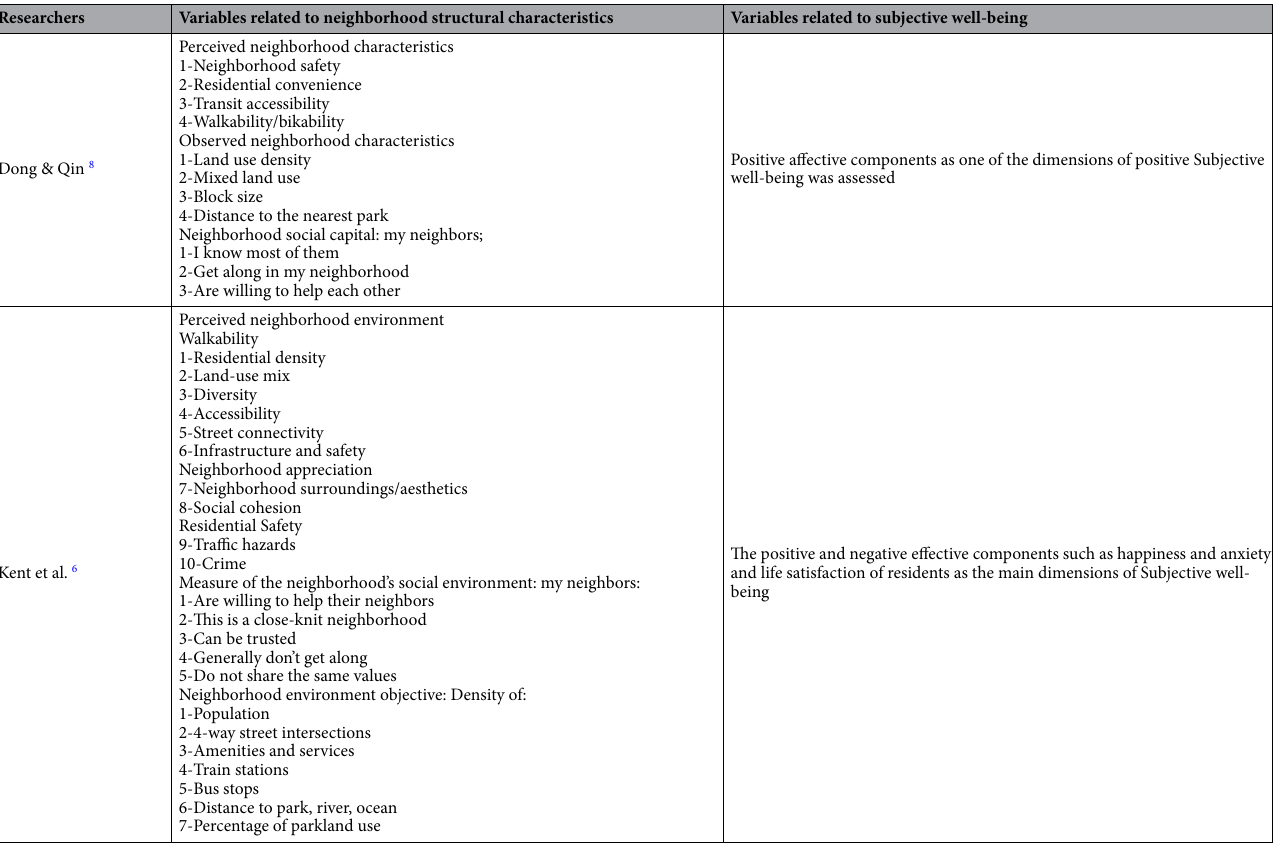
Table 1. Analysis of the studies conducted on significance of the relationship between neighborhood environment characteristics and subjective well-being of citizens.